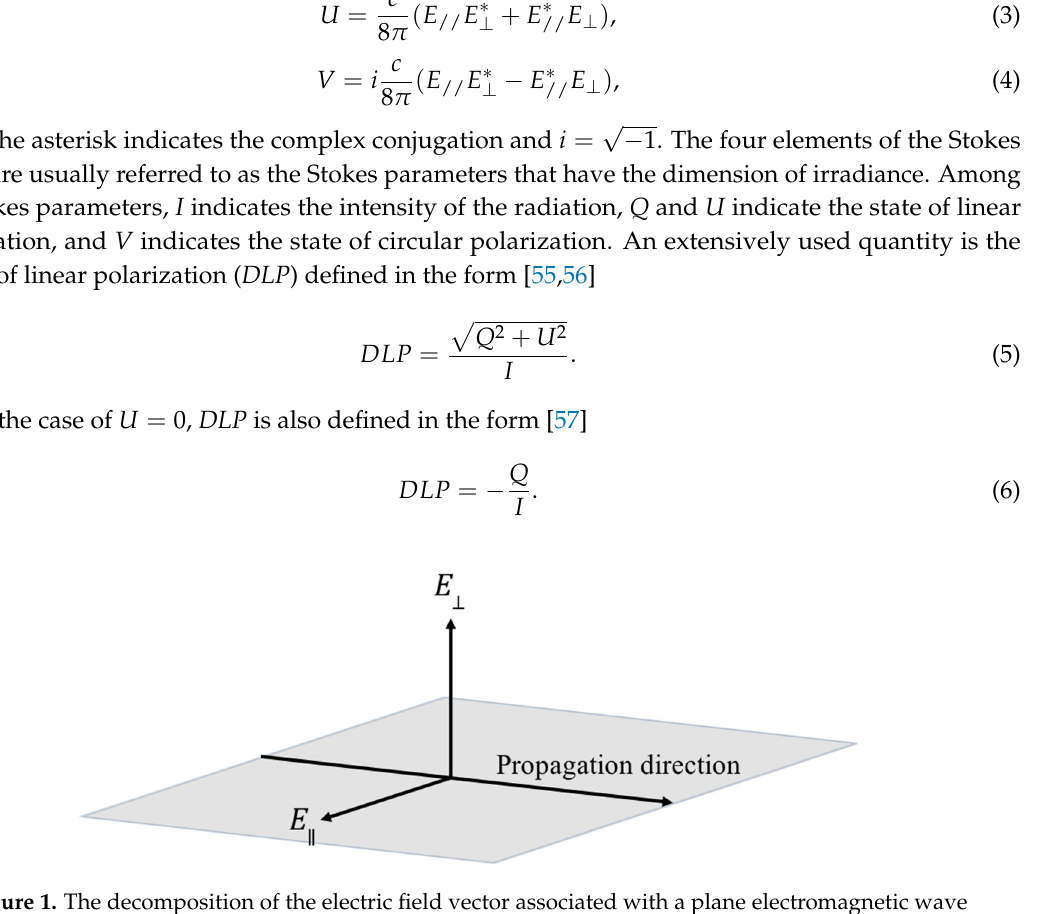
Figure 1. The decomposition of the electric field vector associated with a plane electromagnetic wave into parallel and perpendicular components ( E // and E ⊥ ) with respect to a reference